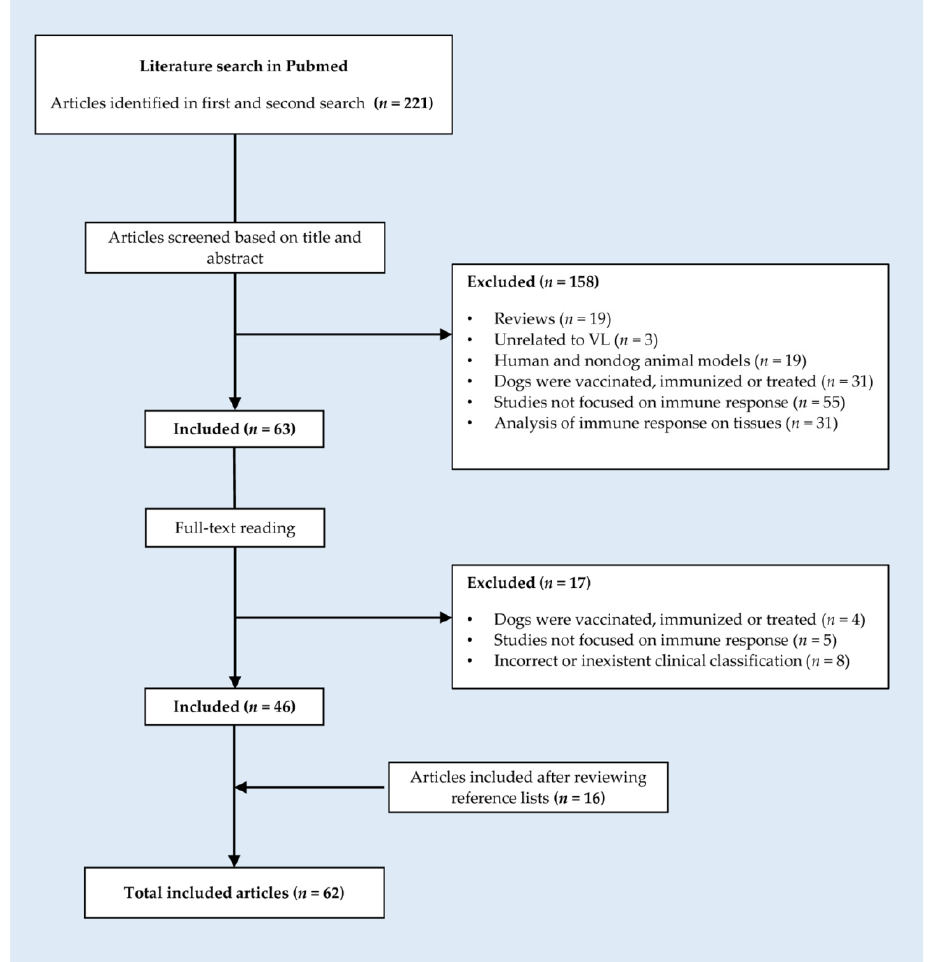
Figure 1. Flow diagram showing the steps followed to select the articles included in this review.